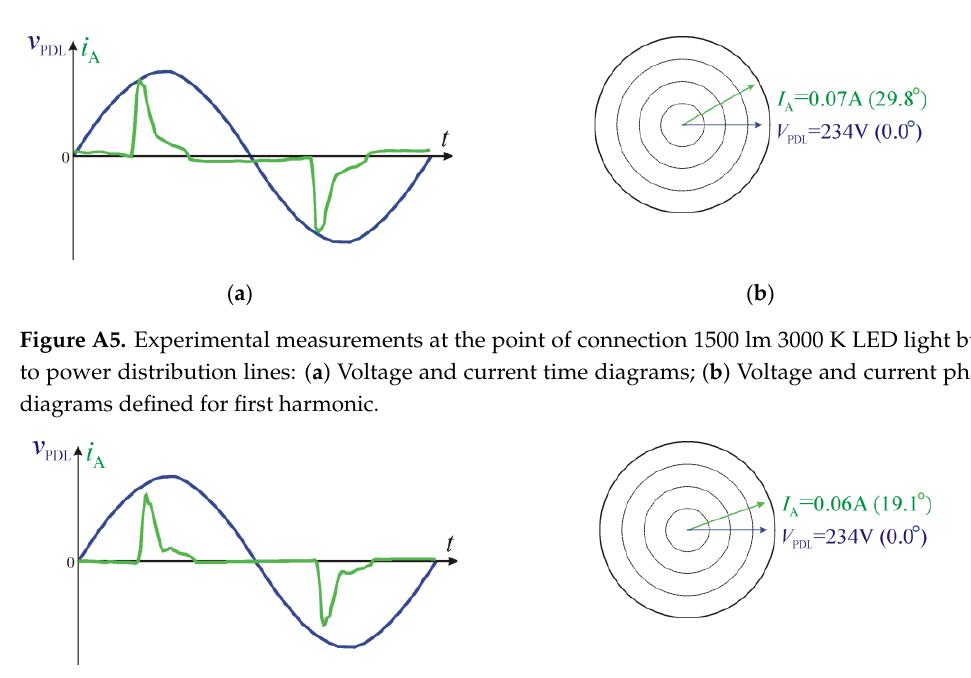
Figure A4. E xperimental measurements at the point of connection 1850 lm 4000 K LED light bulb to PDL: ( a ) Voltage and current time diagrams; ( b ) Voltage and current phase diagrams defined for first harmonic.